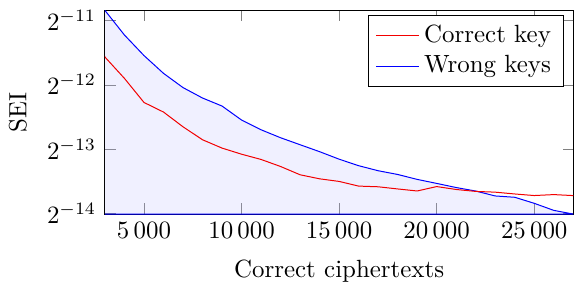
Figure 5: Attacks on 32-bit bitsliced SW AES, STM32 F3, detection countermeasure. SEI of the correct key (SEI R ) vs. best SEI for a wrong key (SEI ∗ 22 000 correct ciphertexts were required, stemming from about 130 000 faulted encryptions.